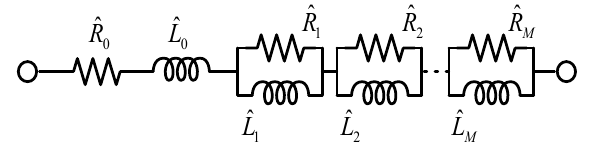
Figure 3. Foster equivalent network of order M .